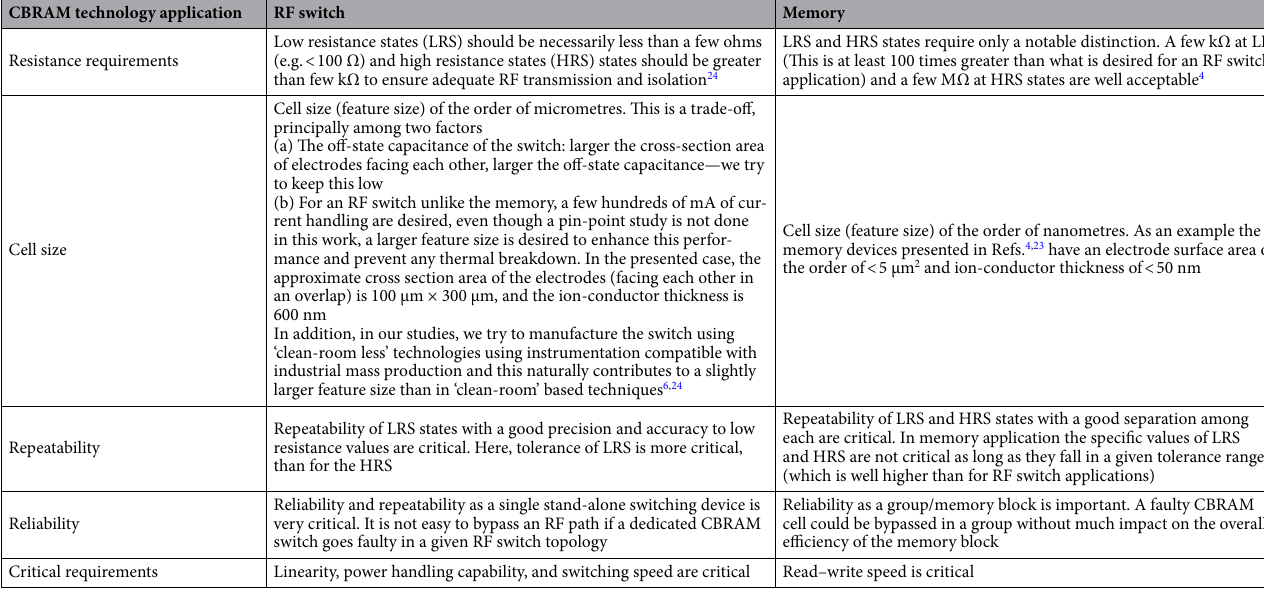
Table 1. Brief comparison of performance/design parameters of CBRAM technology as an RF switch and as a